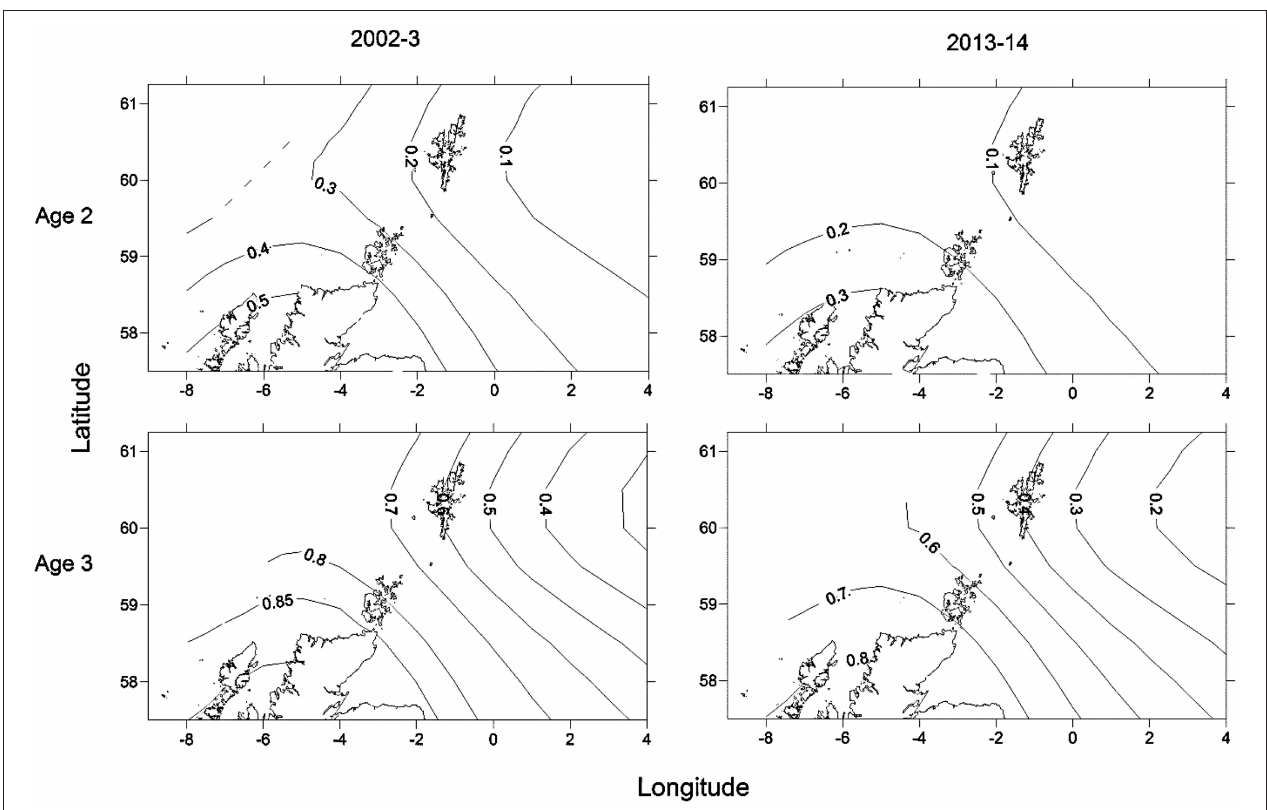
FIGURE 3 | Predicted spatial variation in proportion mature for an age 2, 40cm and an age 3, 50cm female for the two sampling periods. Numbers refer to proportion mature at age isolines showing the decrease in proportion mature from south west to north east.